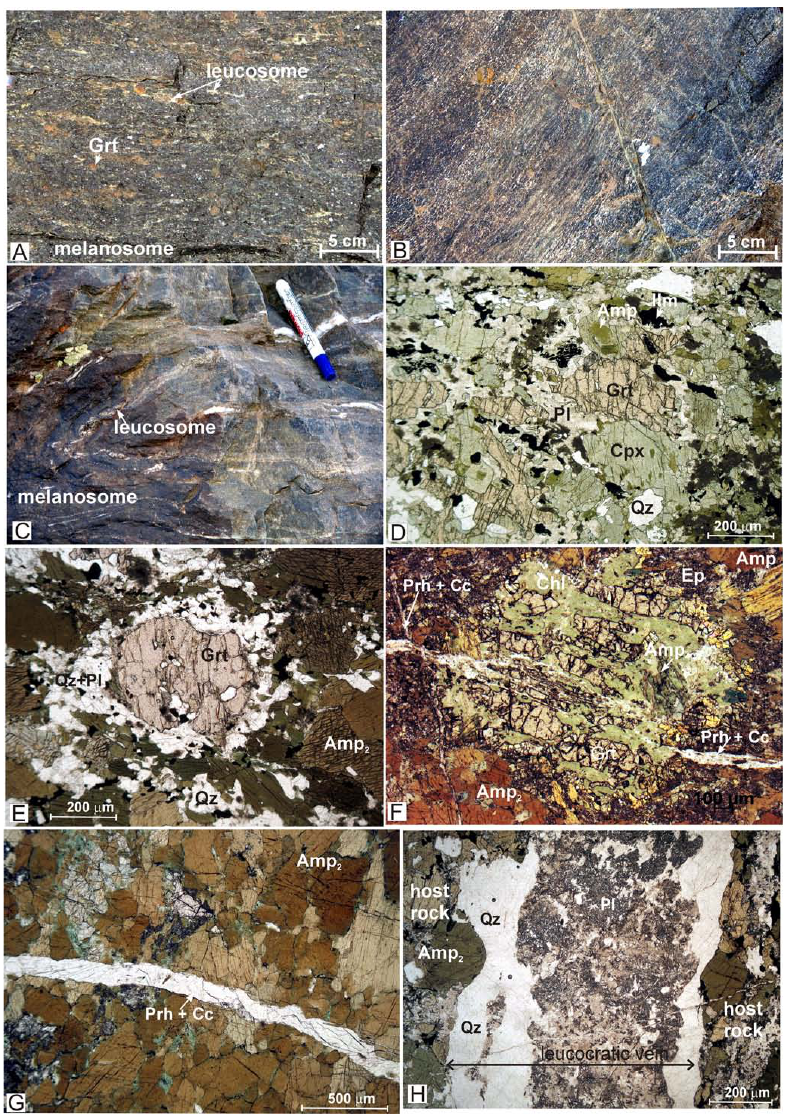
Fig. 3. (A) – (C) Granulite texture at the meso-scale. Note the presence of millimetric-to-centimetric leucocratic layers and patches that impart a stromatic texture to the rock. (D) – (E) Matrix assemblages at the thin section scale showing poikiloblastic garnet and clinopy- roxene. Amphibole-plagioclase forms the main inclusion assemblage. Quartz-Plagioclase films surround garnet. (F) Porpyroclastic garnet surrounded by coronitic amphibole and late chlorite overgrowth. (G) Prehnite-calcite vein cutting across matrix amphibole. (H) Plagioclase alteration in